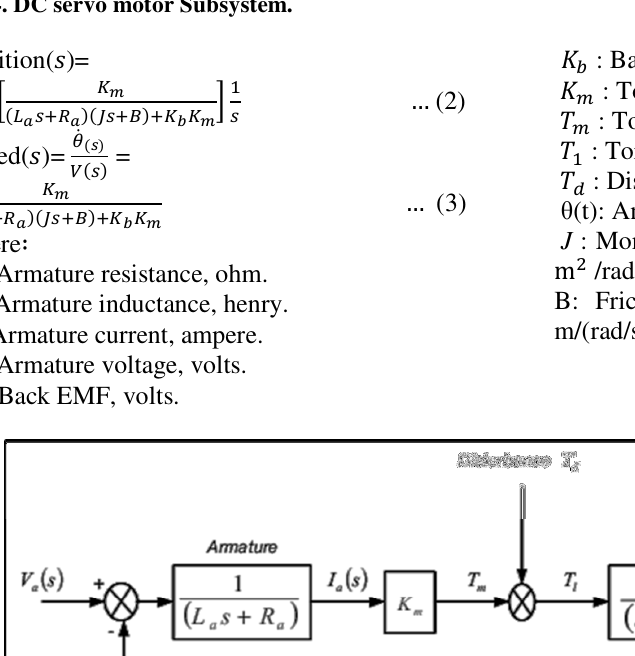
Fig. 4. DC servo motor Subsystem.